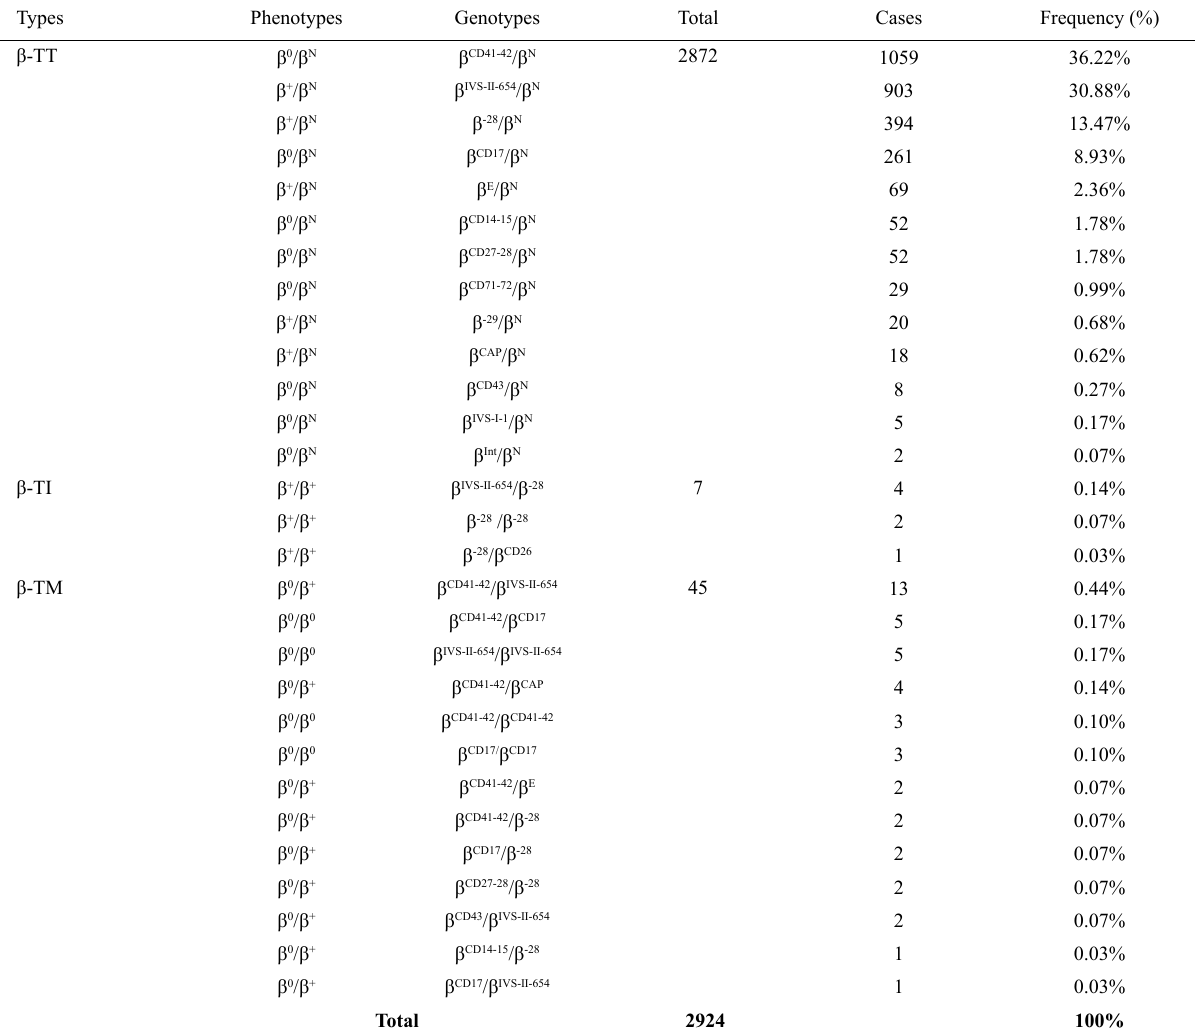
Table 2 – Distribution of β-thal genotypes in